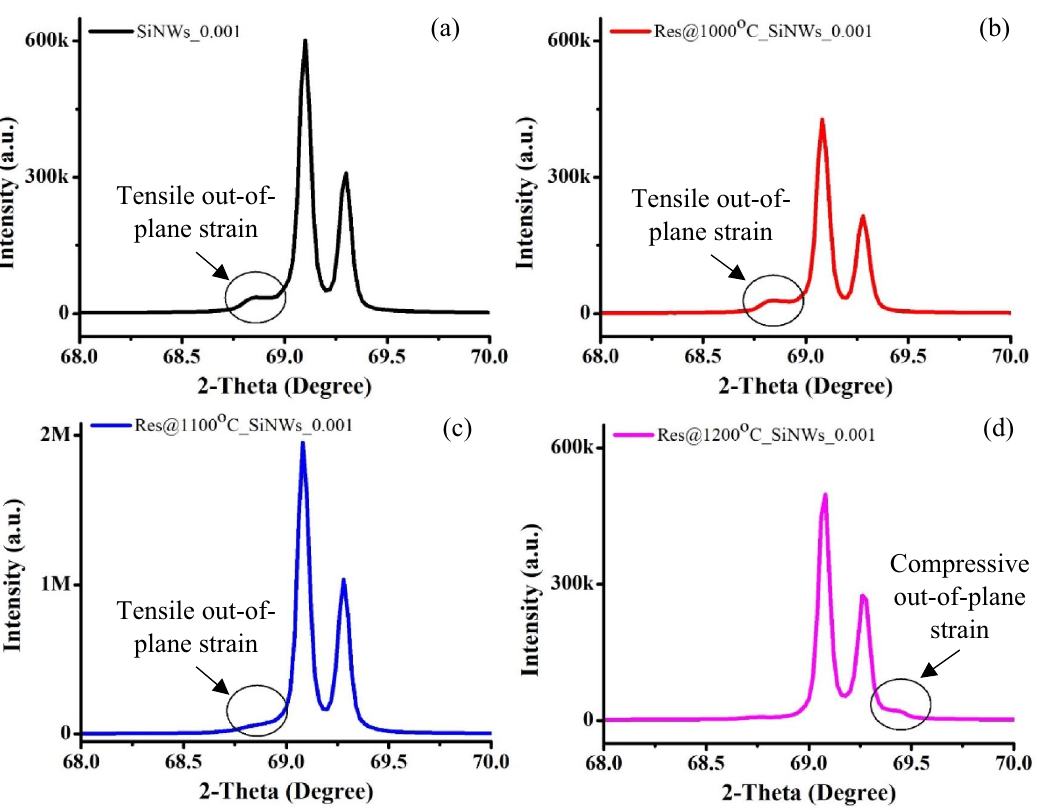
Figure 9. XRD pattern of pristine ( a ) and sintered SiNWs ( b , c , d ). A black color circle indicates the strain produced on the NWs. The tensile out-of-strain is highest in the pristine NWs, followed by sintered NWs (1000 °C). The tensile out-of-strain relaxes in sintered NWs (1100 °C). The tensile out-of-strain is converted to compressive out-of-strain for NWs sintered at 1200